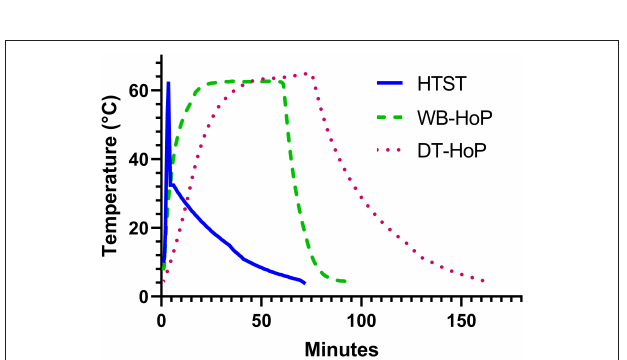
FIGURE 2 | Time-temperature curves of human-milk samples during high-temperature short-time treatment (HTST, solid line), water-bath Holder pasteurization (WB-HoP, dashed line) and dry-tempering Holder pasteurization (DT-HoP, dotted line).